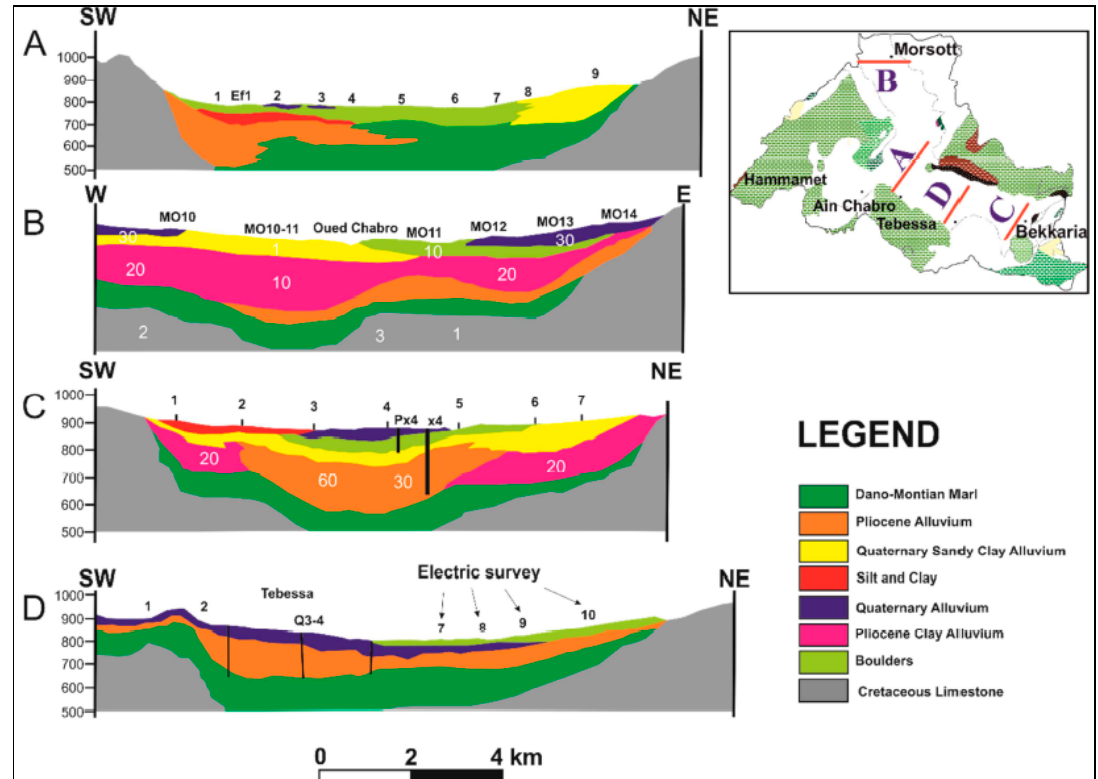
Figure 2. Geoelectrical cross-sections in the Tebessa-Morsott plain [33].